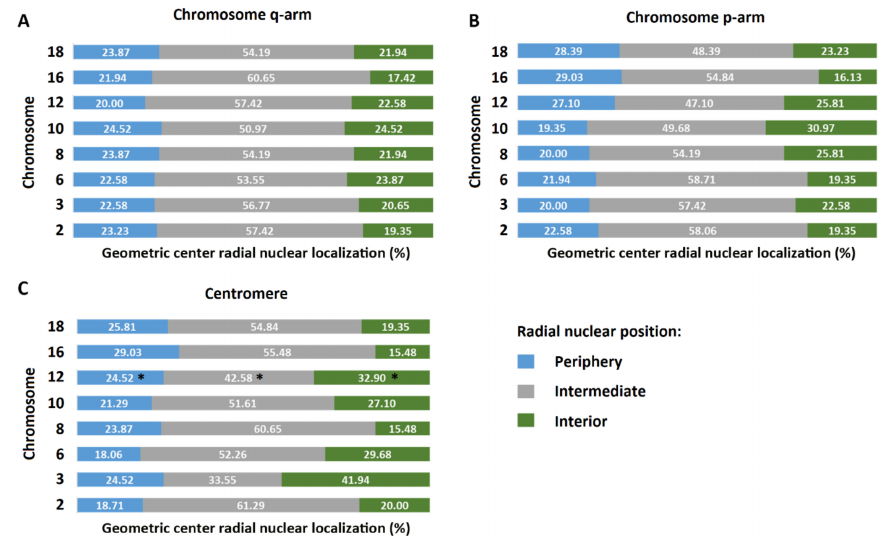
Figure3. Mean3Dradialpositioningofthecentromeres, p-andq-armsofeightdi ff erentchromosomesin human sperm from five normozoospermic subjects demonstrates relative consistent radial organization for the p- and q-arms, with more variation in organization for the centromeres. A minimum of 30 nuclei were examined per FISH probe target, per patient. The data displayed is based on the mean nuclear distribution of the geometric center of each probe targeted in a minimum of a 150 cells in the five patients enrolled in the study. All chromosome centromeres, p- and q-arms were non-randomly distributed in sperm nuclei ( p ≤ 0.05; χ 2 goodness-of-fit) with the exception of the chromosome 12 centromere which was randomly organized ( p ≥ 0.05) *. The nuclear positions of the geometric centers of the q-arms, p-arms and centromeres for each of the eight investigated chromosomes is shown in panels A , B and C ,